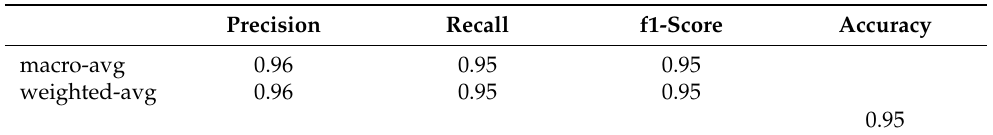
Table 1. Accuracy, precision, recall, and f1-score metrics for the face recognition system applied to the M2FRED dataset. Precision Recall f1-Score Accuracy macro-avg 0.96